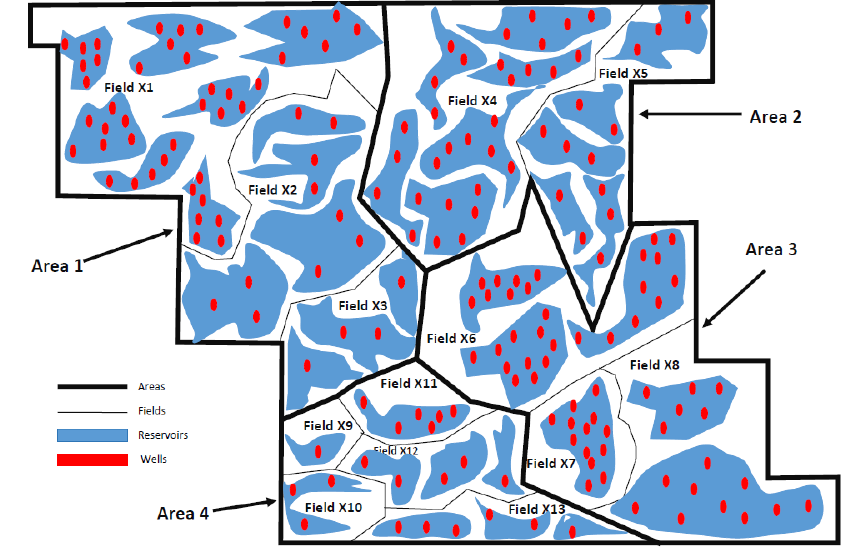
Figure 2. Schematic diagram of Block K (Angola) showing the areas, fields, reservoirs and wells. See Table 1 for detailed breakdown of the distribution of the areas, fields, reservoirs and wells for the Block